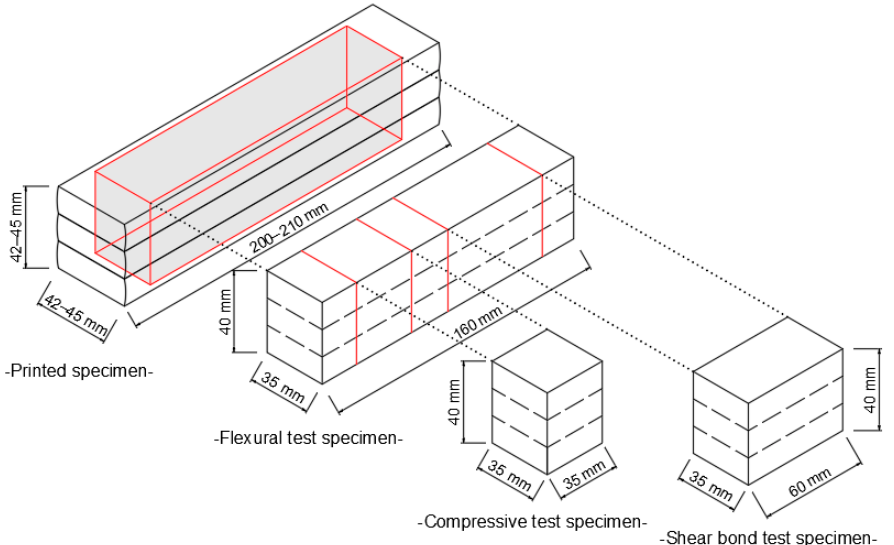
Figure 6. The specimen preparation for mechanical tests.